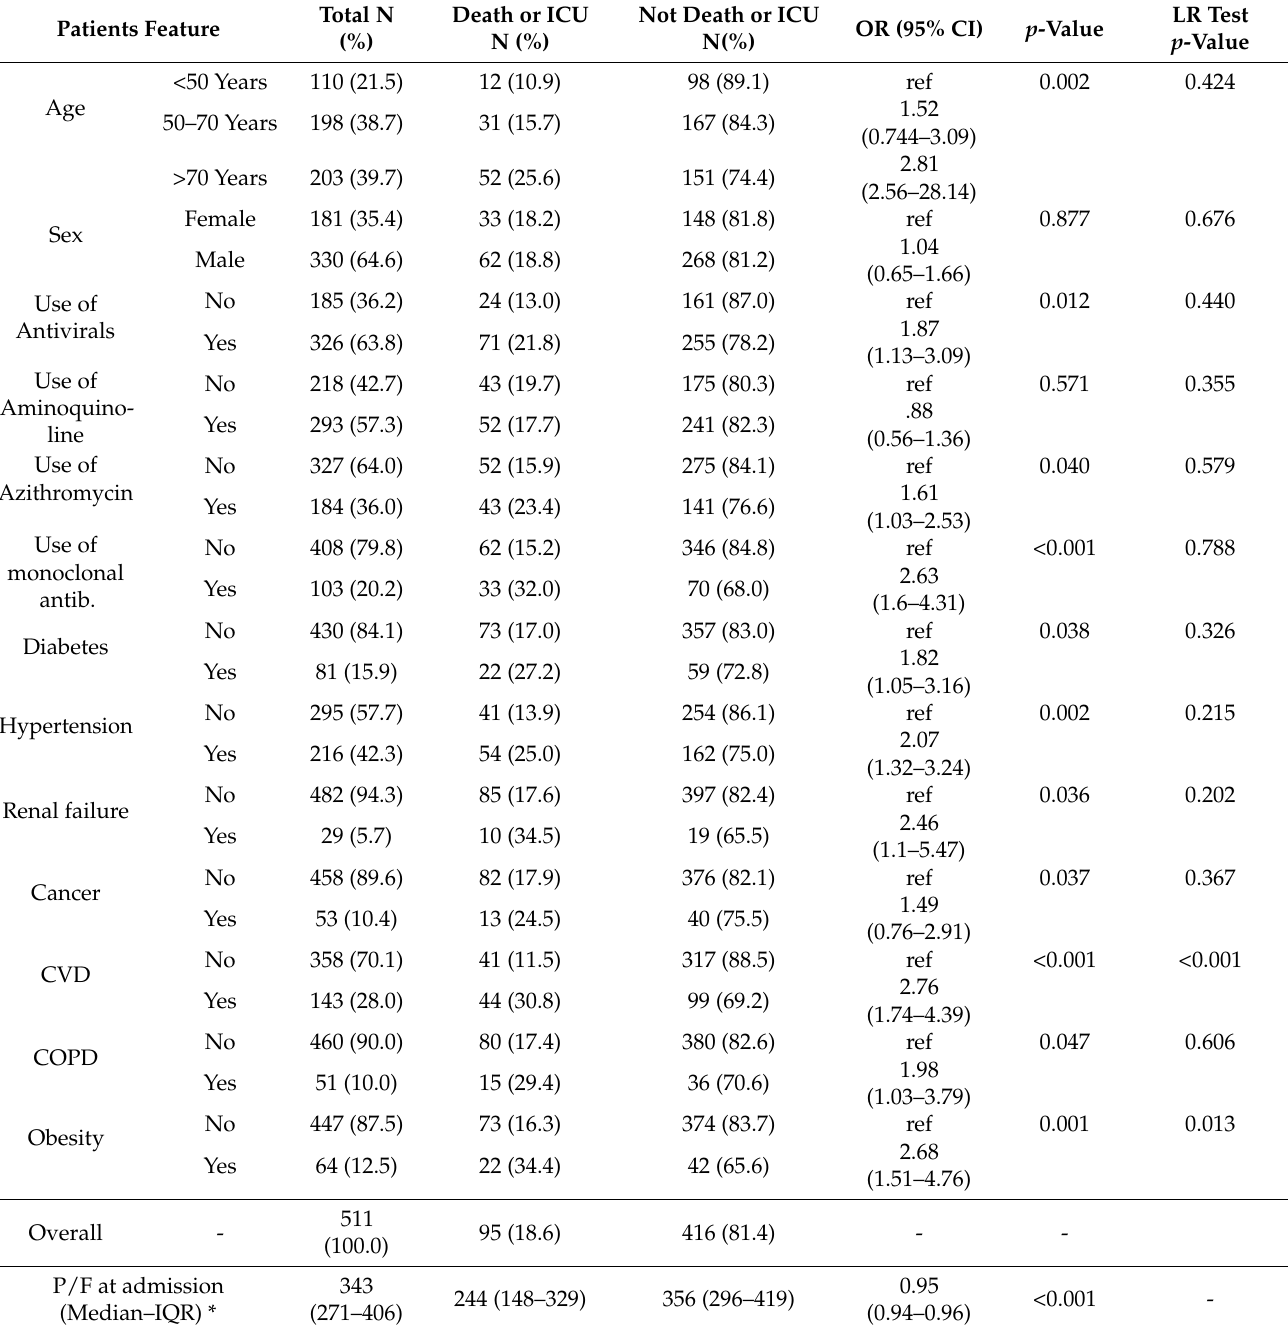
Table 4. Patients’ demographic, co-morbidities, and univariate analysis results with respect to death within 28 days or ICU. LR Test p -value indicates the likelihood-ratio test performed between the unadjusted model and the adjusted model with one comorbidity at